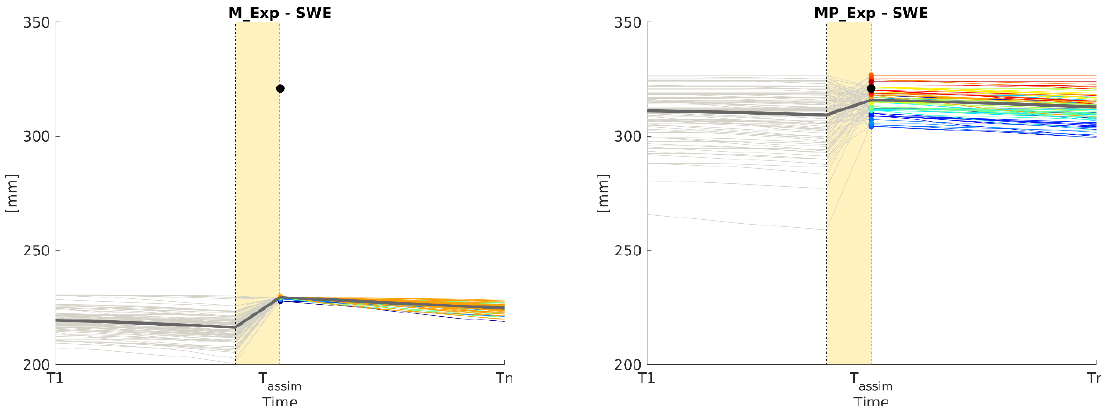
Figure 8. Particle resampling at an assimilation time step of SWE observation: M_Exp vs. MP_Exp. In grey are the ensemble members, the ensemble mean is represented more thickly; the black dot is the observation; and the resampled particles are